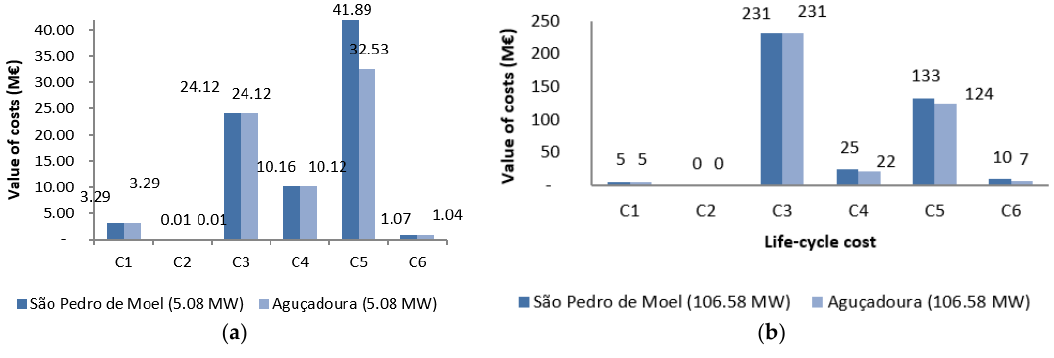
Figure 11. Life-cycle cost of a 5.08 MW ( a ) and 106.58 MW ( b ) floating offshore wind farm.